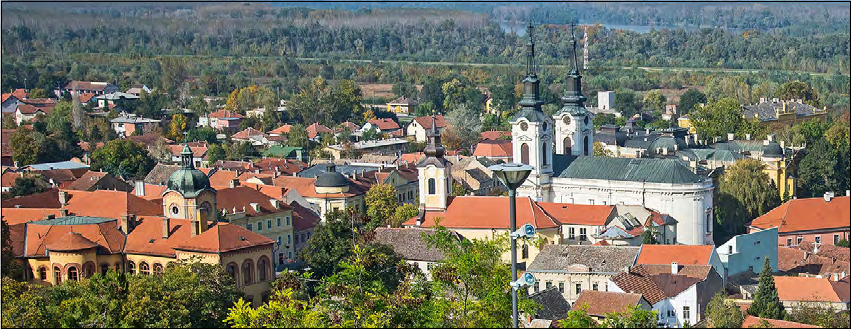
Figure 4. The city Center of Sremski Karlovci (landscape units) Source: Vojvodina Environmental Movement, Sremski